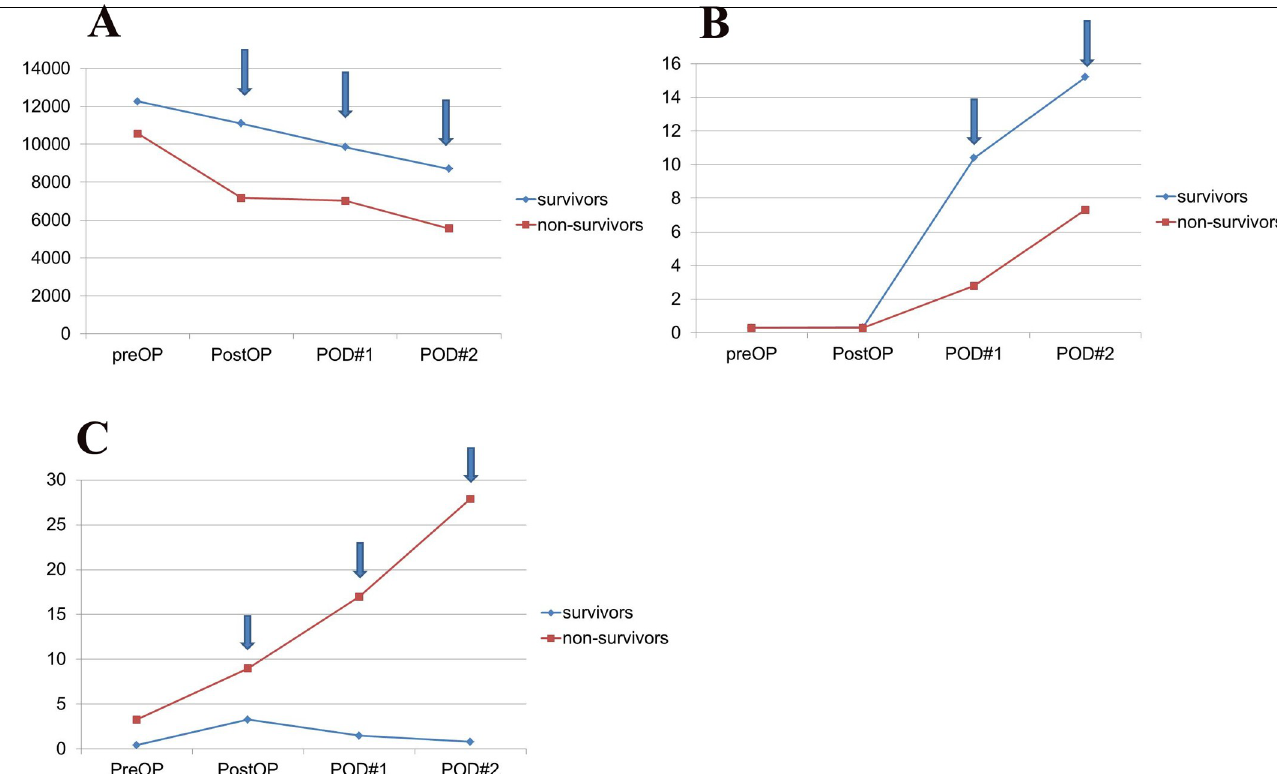
Fig 2. (A) White blood cell (WBC) count during the perioperative period. The mean WBC counts of survivors were significantly higher than that of the non- survivors on the immediate postoperative day, postoperative day 1, and postoperative day 2. (B) C-reactive protein (CRP) during the perioperative period. The mean CRP levels of the survivors were significantly higher than that of the non-survivors on postoperative day 1 and postoperative day 2. (C) Delta neutrophil index (DNI) during the perioperative period. The mean DNI of the non-survivors was significantly higher than that of the survivors on the immediate postoperative day, postoperative day 1, and postoperative day